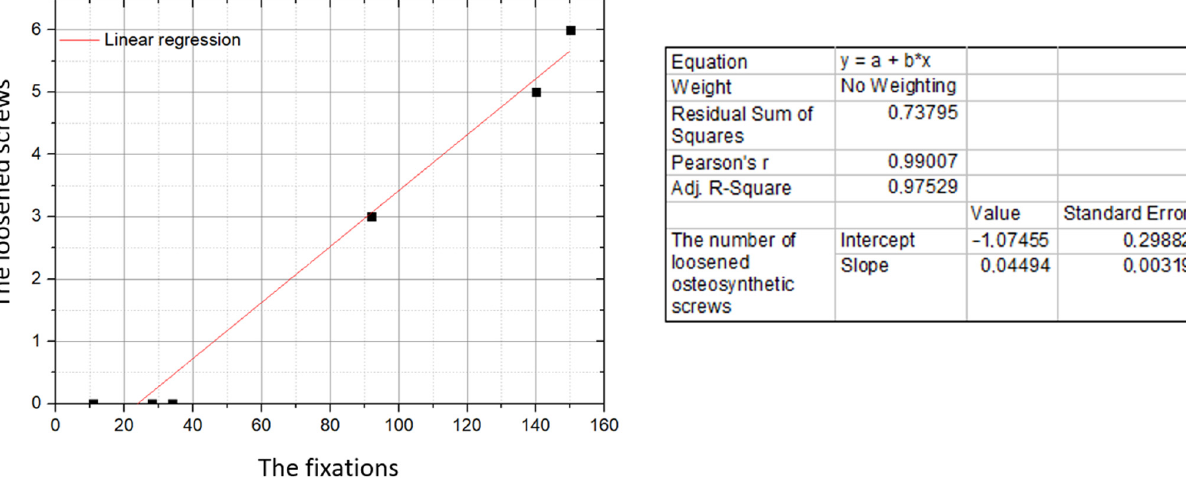
Figure 2. Correlation between the number of loosened osteosynthetic screws (vertical axis) and the number of fixations with 3D mini-plates (horizontal axis). Data for individual shapes of 3D